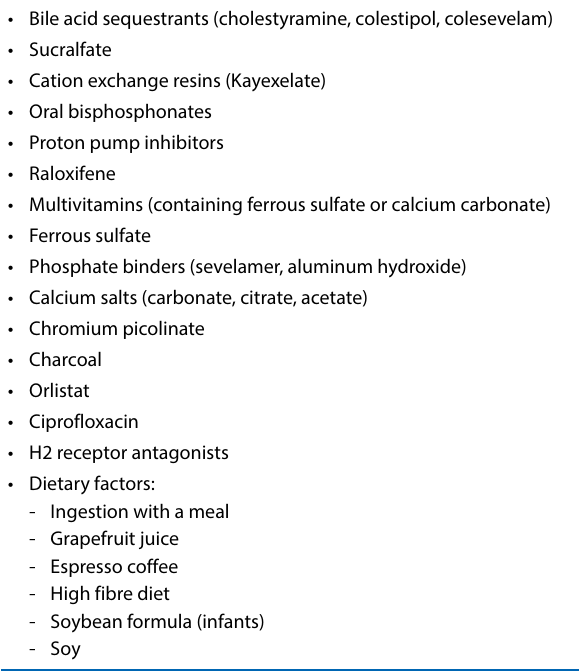
Table II: Factors affecting the absorption of